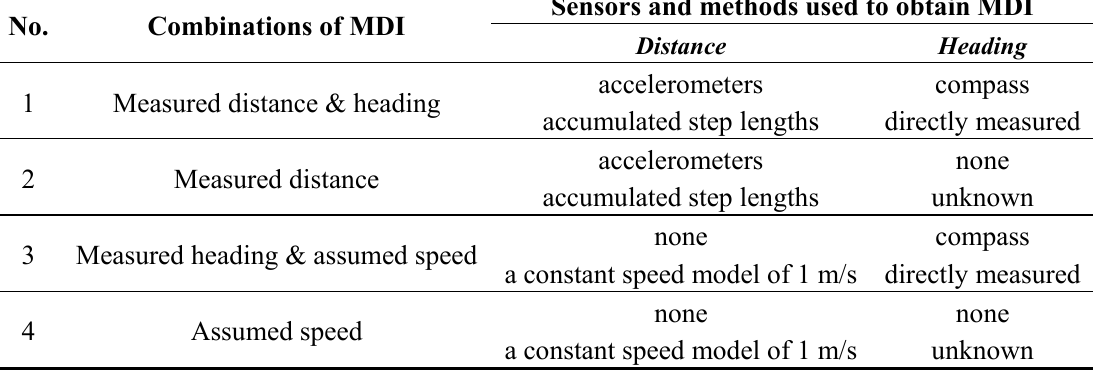
Table 1. Definitions of situations that use different combinations of motion dynamics information (MDI).